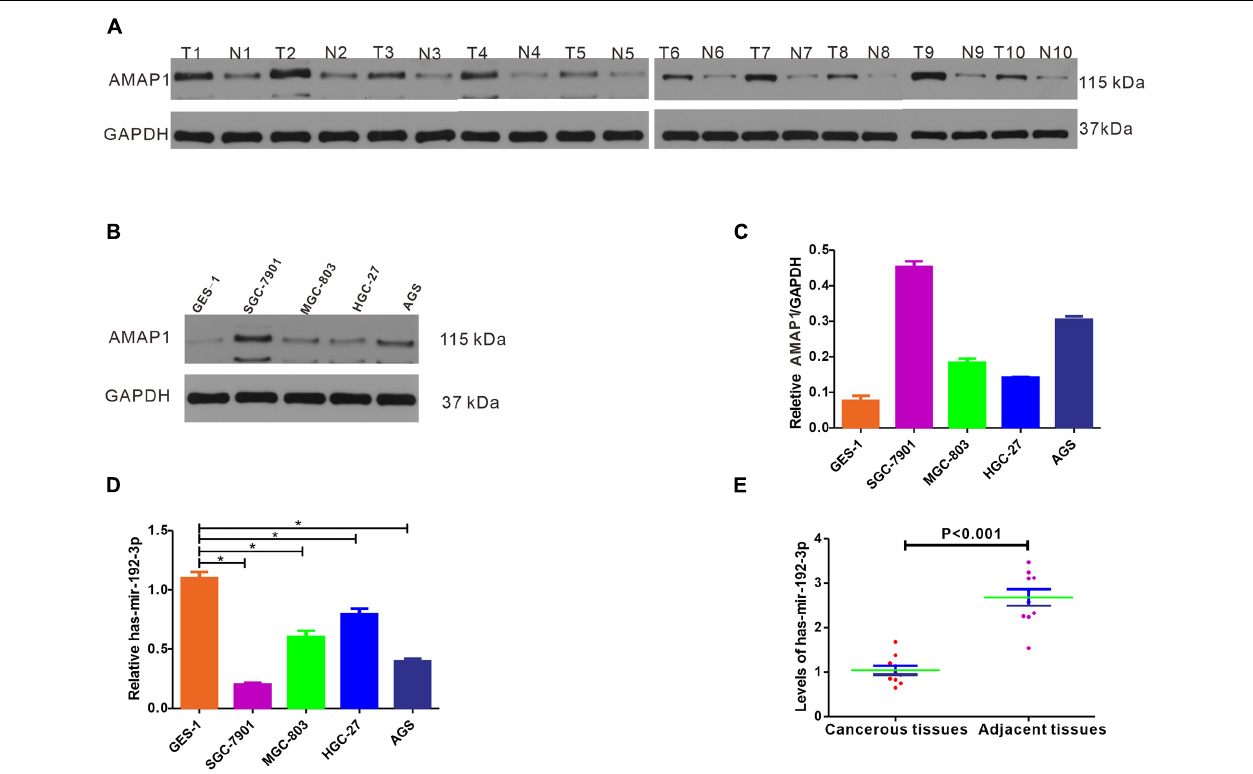
FIGURE 7 | Expression of AMAP1 protein and miR-192-3p in human tissues and cell lines. (A) AMAP1 protein was increased in gastric cancerous specimens compared with the matched normal tissues by western blot. (B) AMAP1 protein was up-regulated in gastric cancerous cell lines compared with GES-1 by western blot. (C) Quantitative analysis of AMAP1protein in cancerous and normal gastric cell lines. (D) Expression of miR-192-3p was lower in gastric cancer cell lines than GES-1 by RT-PCR. (E) Expression of miR-192-3p was down-regulated in gastric cancerous specimens compared to the matched normal tissues by RT-PCR. * P < 0.05.